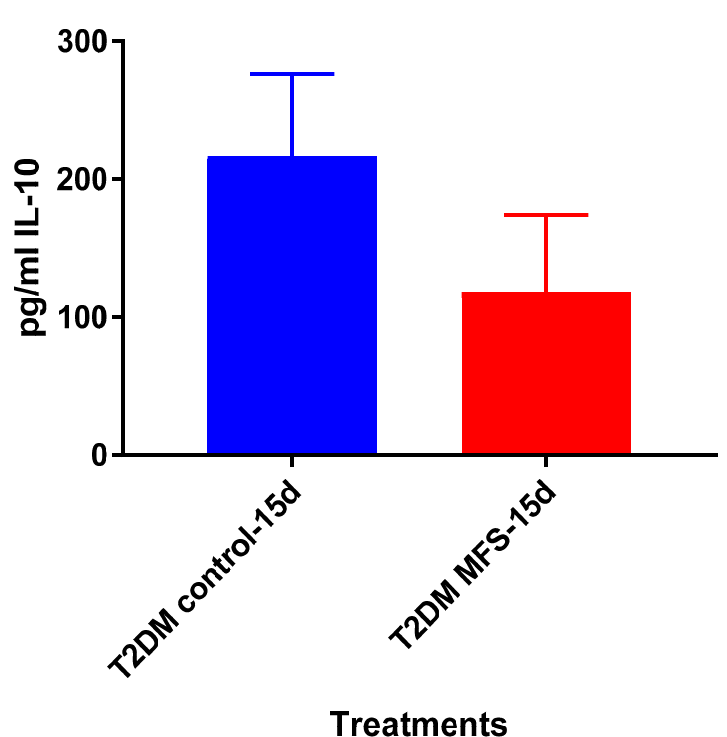
Figure 15. Levels of IL-10 in untreated and MFS-treated granulomas from individuals with T2DM. Assay of IL-10 was performed using an ELISA Ready-Set-Go kit from eBioscience. Data represent means ±SE from six T2DM individuals.